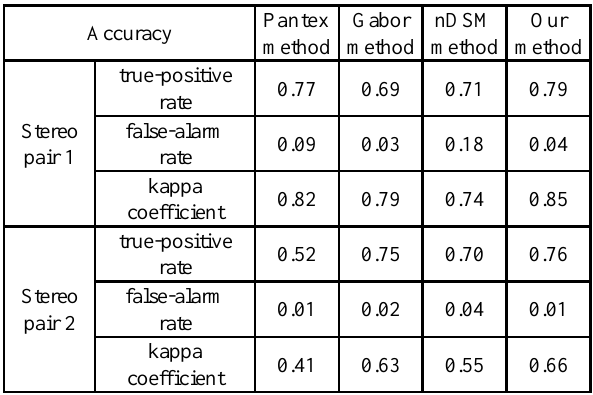
Table 2. Accuracy results of two stereo